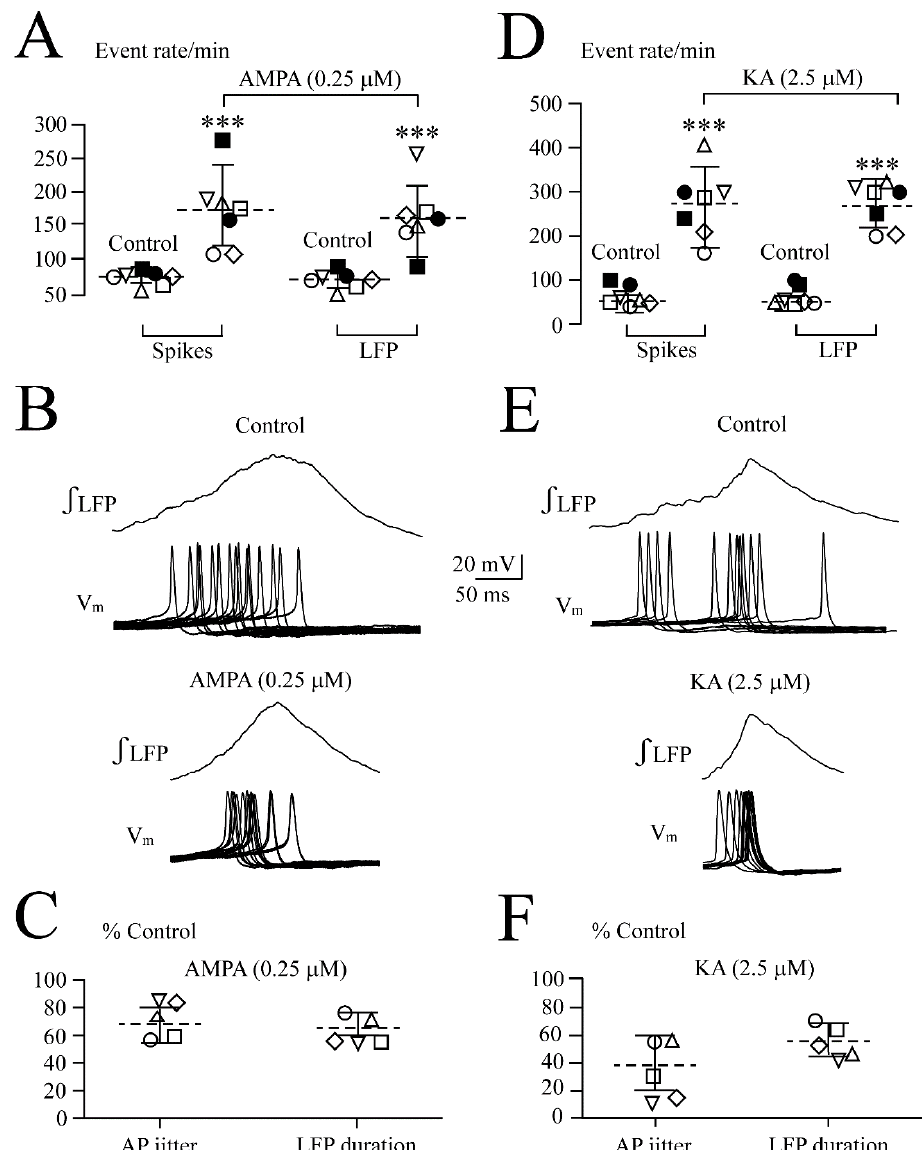
Figure 6. AMPA- and KA-evoked accelerated and less jittered neuronal spiking. ( A ) In seven neurons from different slices (each represented by the same symbol), AMPA similarly accelerated neuronal spiking and LFP rate. The lines indicate the mean values (dotted line) ± SD (solid line). Significance (*** p < 0.001) was determined with a one-way ANOVA with Dunnett’s post-test (*** p < 0.001). As exemplified for one neuron in ( B ), AMPA reduced spike jitter in a similar fashion as it shortened the LFP event as analyzed in five slices ( C ). ( D – F ) show corresponding effects of 2.5 µM KA on different slices (each represented by the same symbol). The lines indicate the mean values (dotted line) ± SD (solid line), significance was determined with two-tailed paired t -test.